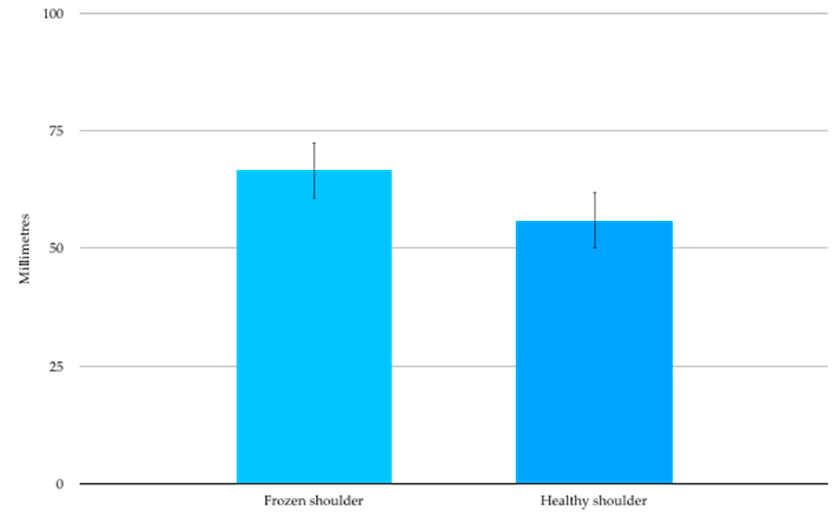
Figure 3. Two-point Discrimination mean (SE) thresholds in millimetres.